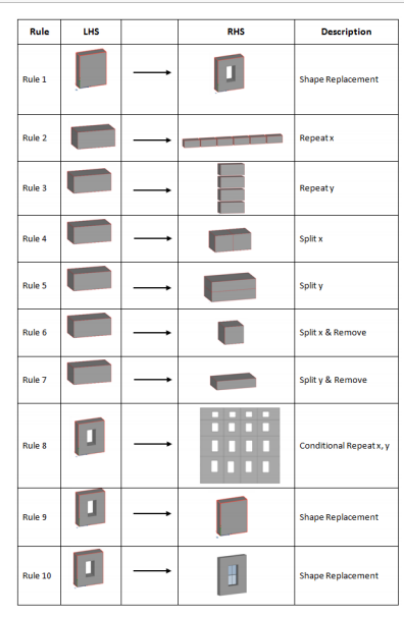
Table 1. Shape rules { 𝑅 } for parametric shape grammar design.